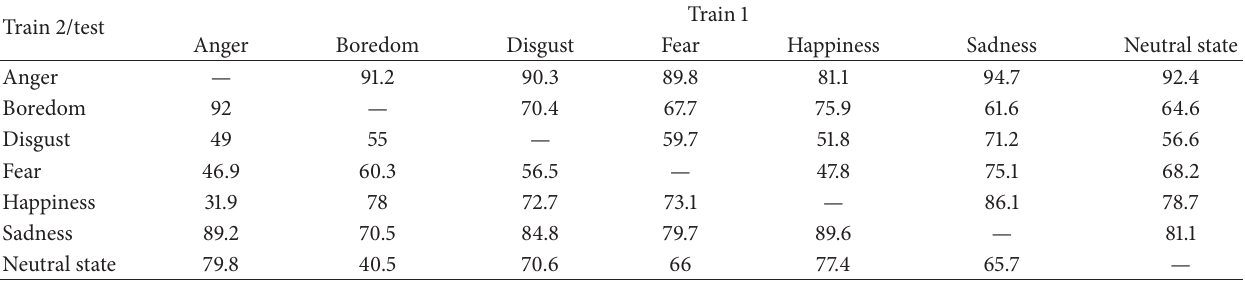
Table 7: 𝐾 -nearest neighbours classification accuracy for different combinations of emotions [%].